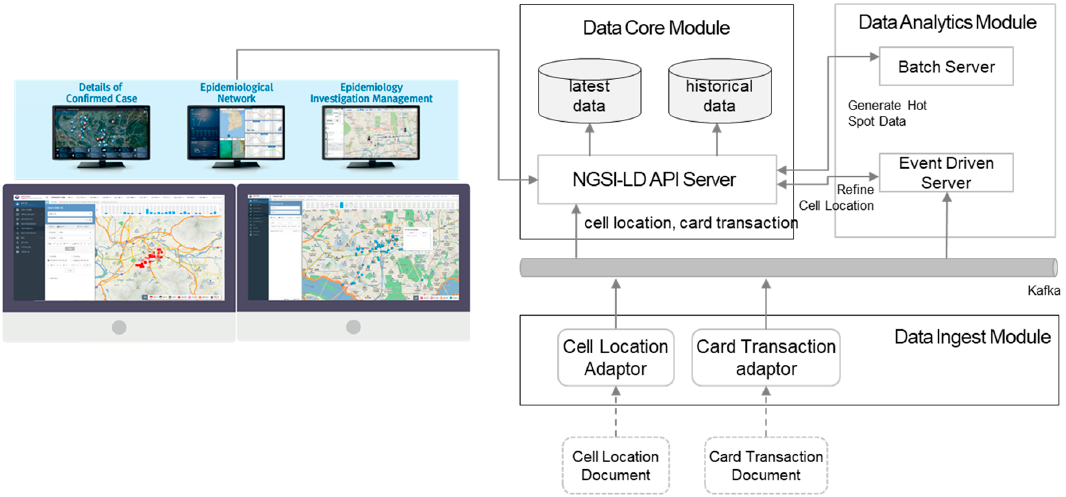
Figure 9. COVID-19 Epidemiological Investigation Supporting System (EISS) system.